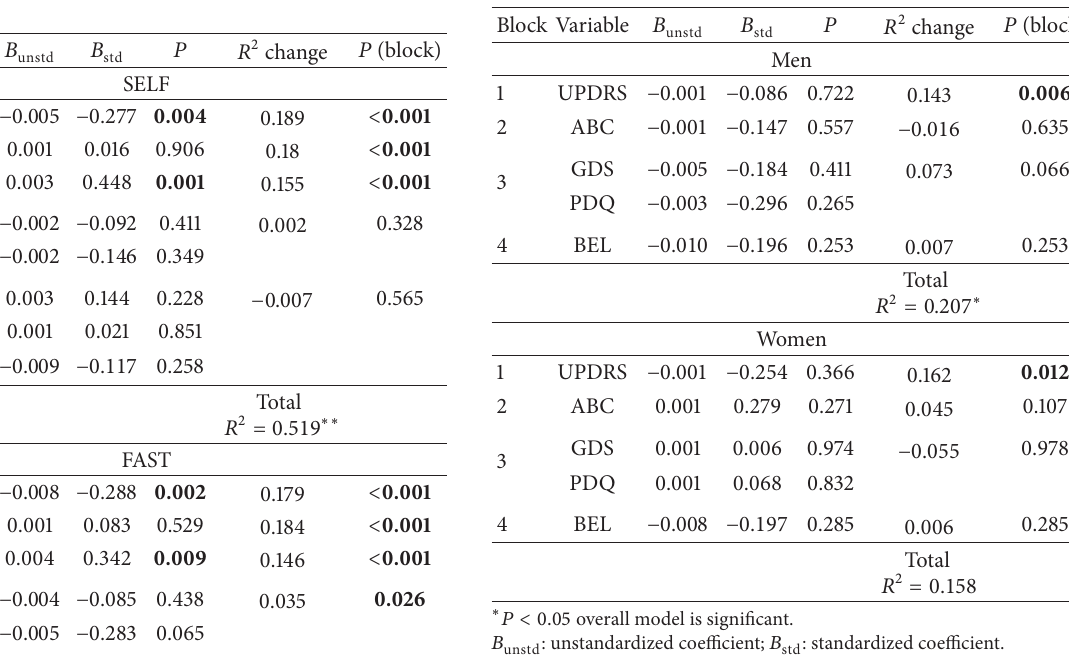
Table 4: Regression model results for DIFF in men and